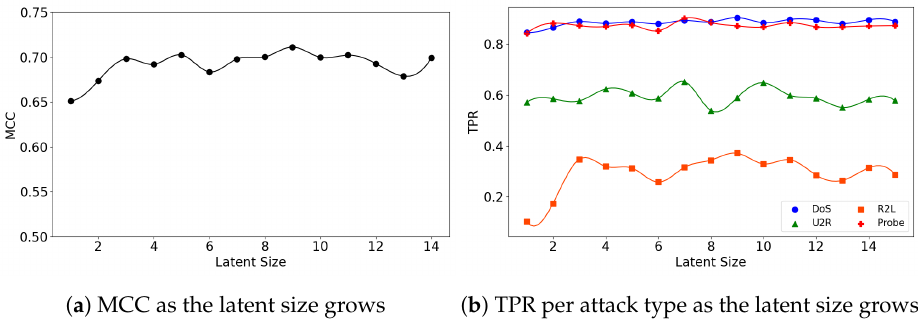
Figure 6. The results of evaluation using the NSL-KDD dataset when the (7,64) model is